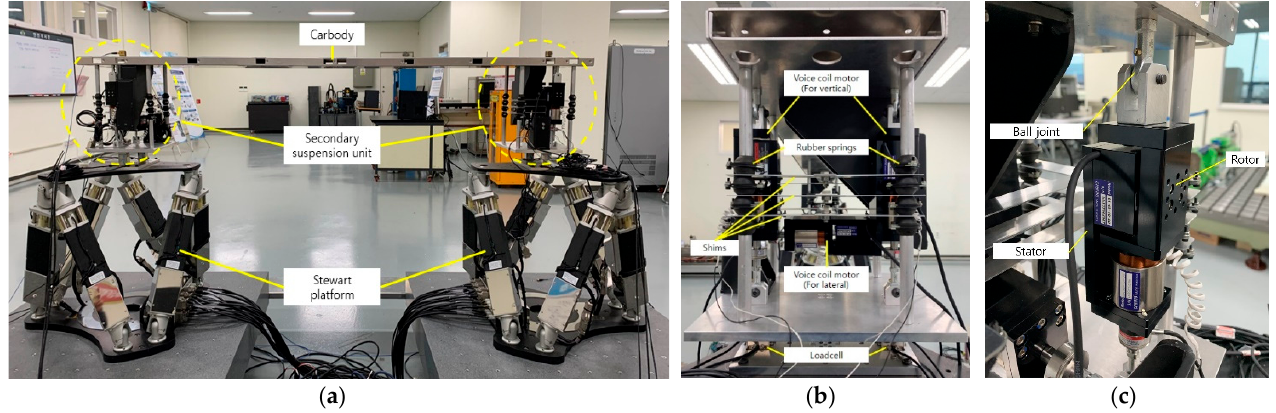
Figure 3. Reduced-scale vehicle model: ( a ) full view, ( b ) secondary suspension unit, ( c ) voice coil motor.